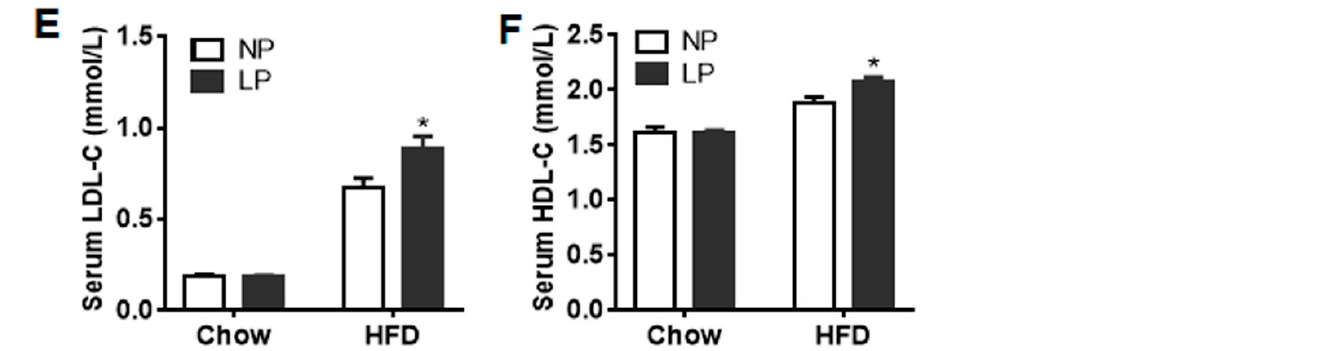
Figure 2. Maternal low-protein diet during puberty and adulthood aggravated hepatic steatosis of offspring under HFD condition. ( A ) Oil-red O staining and H&E staining with the liver of offspring. Bars equal to 100 μ m. ( B ) TAG content in the liver. ( C ) TAG content in the serum. ( D ) TC content in the serum. ( E ) LDL-C content in the serum. ( F ) HDL-C content in the serum. n = 7–9 for each group. Data were expressed as mean ± SE. NP, normal protein diet; LP, low protein diet. * p < 0.05, ** p < 0.01 LP vs. NP.